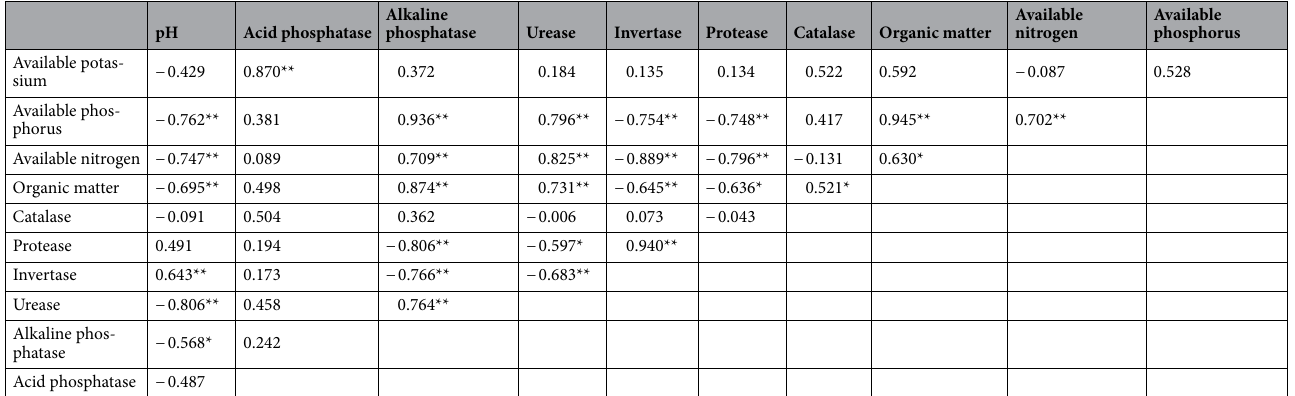
Table 5. Correlation analysis of the bio-chemical factors in the rhizospheric soil of F. taipaiensis with different cultivation years. * p < 0.05, ** p <